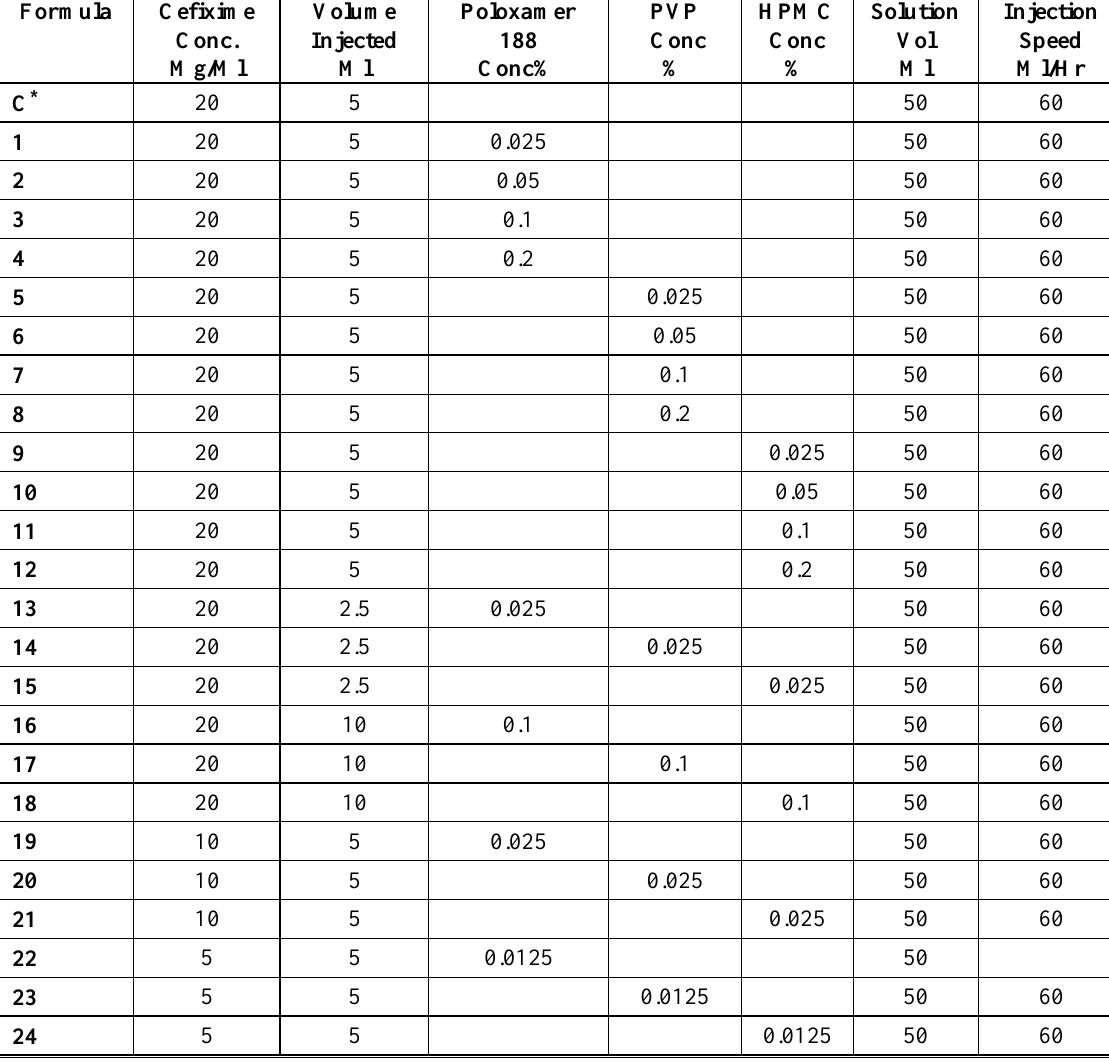
Table 1: Components of various